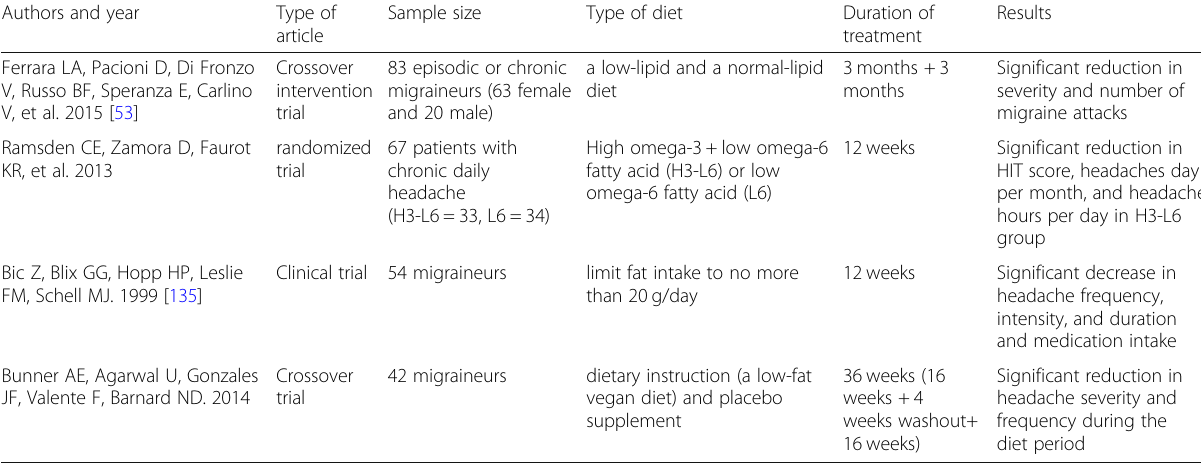
Table 2 Literatures on effects of low fat diet on migraine headache